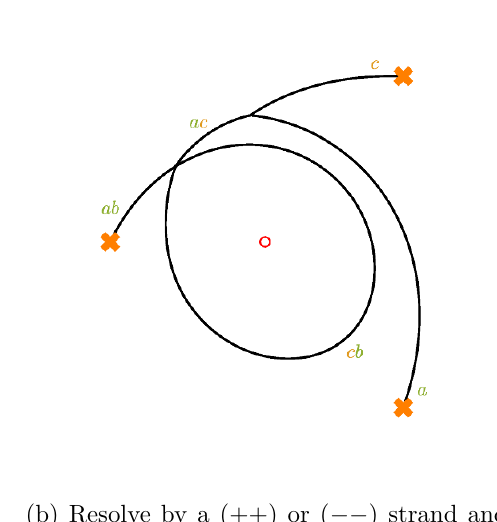
(b) Resolve by a (++) or ( (cid:0)(cid:0) ) strand and detach from bottom branch point. Figure 31. Three torus (cid:12)xed points from K 3 (1 ; 2).